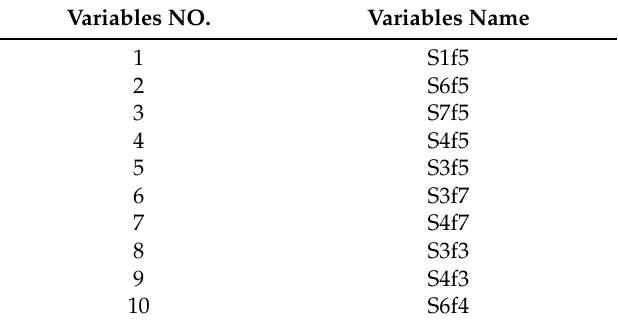
Table 5. The first 10 variables